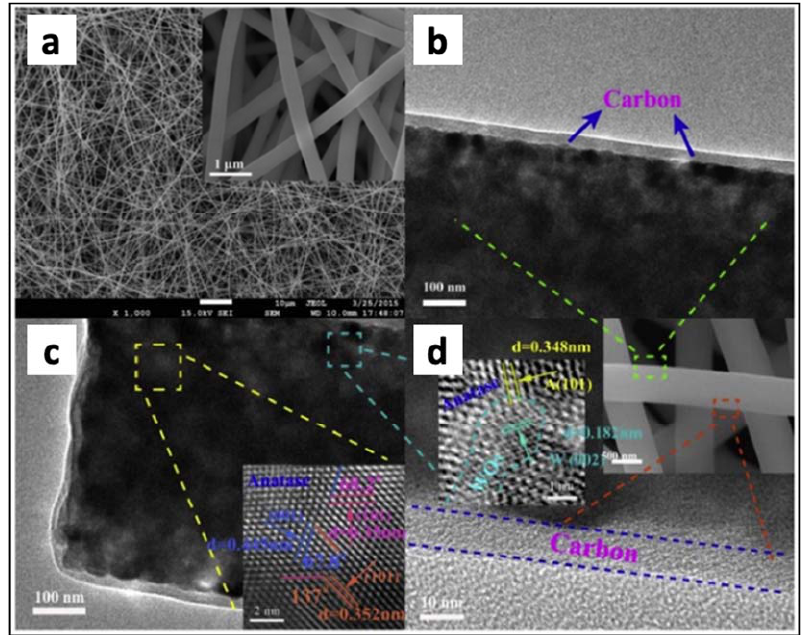
Figure 29. ( a ) FESEM image of the 1% carbon coated TiO 2 /WO 3 nanofibers. (inset: enlarged image of Figure a); ( b – d ) HRTEM images of 1% carbon coated TiO 2 /WO 3 nanofibers. Inset c: HRTEM of the TiO 2 area indicated by yellow imaginary line frame; inset d: HRTEM of the WO 3 area indicated by blue imaginary line frame. Both c and d proved that the nanofiber was coated by a thin carbon layer. Reproduced with permission from reference [148].